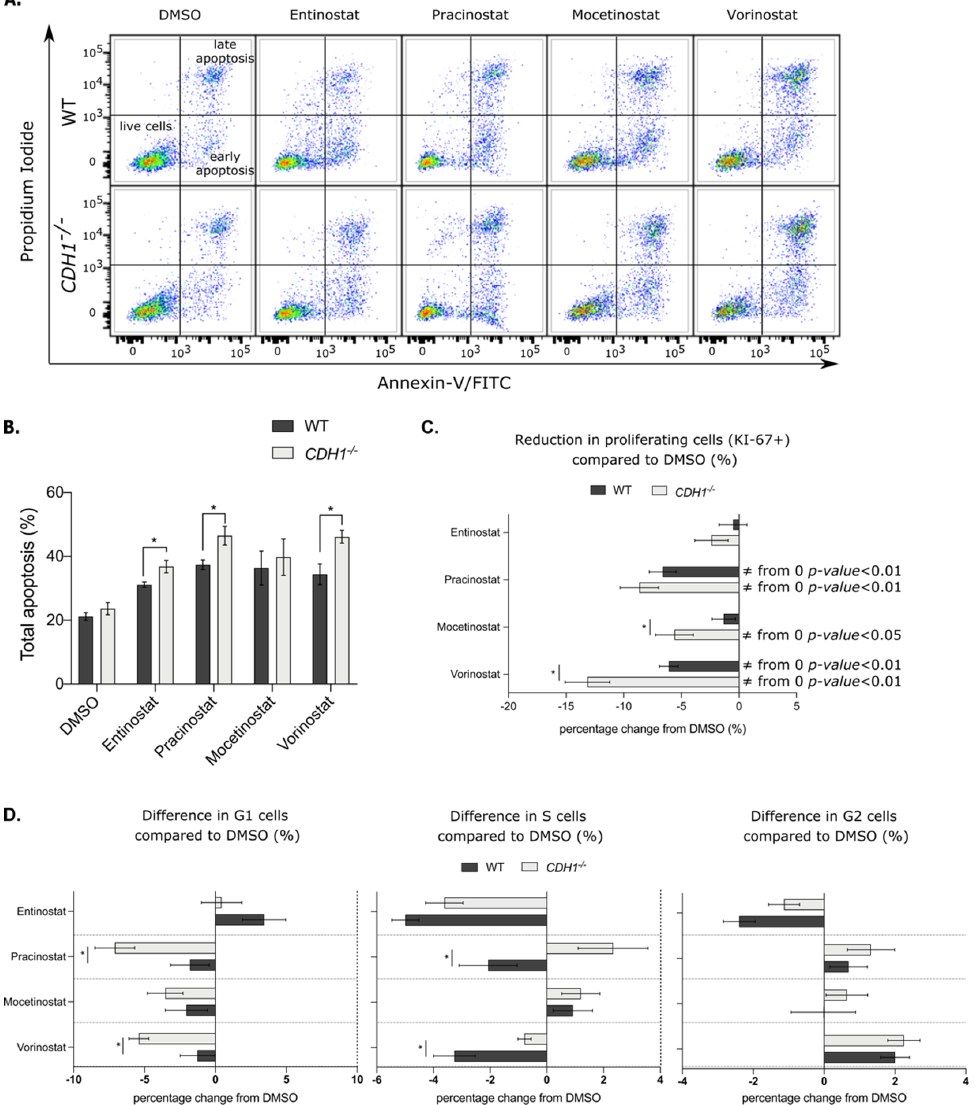
Figure 3. Pan-HDAC inhibitors preferentially induce apoptosis and decrease proliferation in gastric E-cadherin-deficient cells. Apoptosis, proliferation and cell cycle were analyzed in NCI-N87- CDH1 − / − and NCI-N87-WT cells after 48 h of drugging with pan-HDAC inhibitors. ( A ) Apoptosis was analyzed by flow cytometry, using Annexin-V-FITC/propidium iodide staining. Annexin-V- FITC labels a membrane protein expressed by early apoptotic cells and propidium iodide stains nuclear DNA only accessible in apoptotic cells that have lost their membrane permeability (late apoptosis, n = 4–8). ( B ) Percentage of total apoptosis (early and late apoptosis combined) was in- creased in NCI-N87- CDH1 − / − compared to NCI-N87-WT cells after 2.5 μ M entinostat, 0.3 μ M pracinostat and 2.5 μ M vorinostat drugging ( n = 3–5 per compound). ( C ) Total proliferation in NCI- N87- CDH1 − / − and NCI-N87-WT cells was analyzed by flow cytometry after 48 h of drugging with pan-HDAC inhibitors. The difference in KI-67-positive cells for each drug was normalized com- pared to their respective DMSO. Mocetinostat (0.6 μ M) and vorinostat (2.5 μ M) preferentially and significantly decreased proliferation in NCI-N87- CDH1 − / − cells compared to WT ones ( n = 4–7); * = p- value < 0.05 for CDH1 − / − vs. WT and ≠ from 0 for value statistically different to their respective DMSO (value of 0%). ( D ) Difference in percentage of cells in each phase of the cell cycle compared to their respective DMSO by flow cytometry, using propidium iodide staining ( n = 4–5). Pracinostat and vorinostat significantly decreased the percentage of NCI-N87- CDH1 − / − cells in G1 phase and rationally increased the proportion of cells in the S phase.